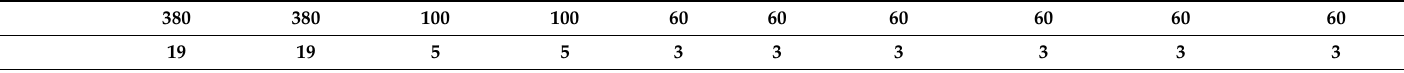
Table A1. Postures, transitions and behaviours for the supervised semi-structured protocol for each task on a per subject basis and for a total of 20 subjects, assuming each task is repeated 3